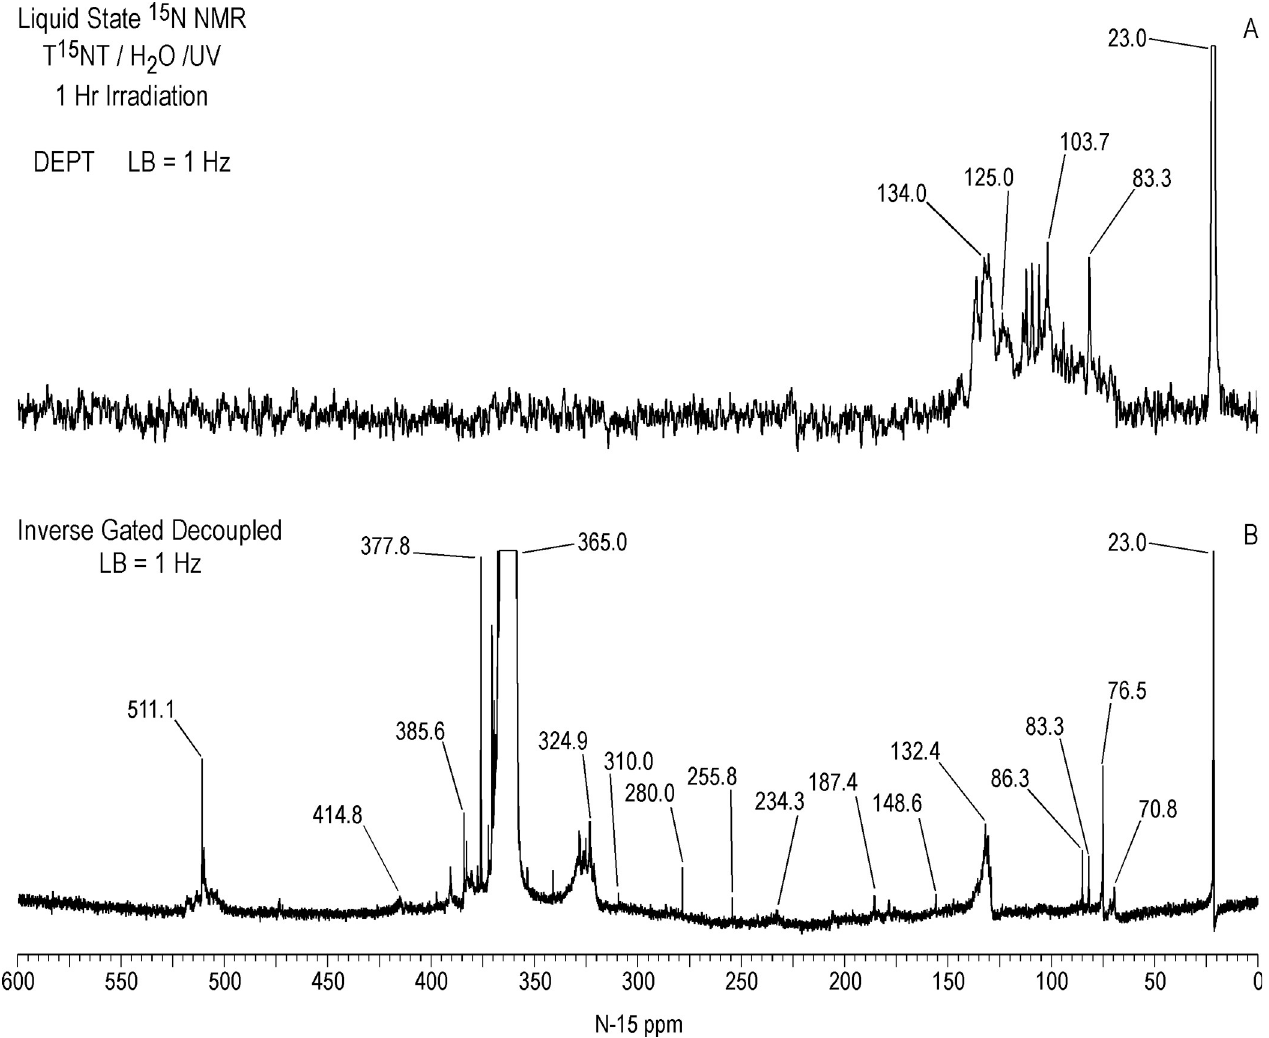
Fig 12. Liquid state N-15 NMR spectra of T 15 NT subjected to lamp irradiation in deionized water. A. DEPT spectrum showing all nitrogens bonded to protons in positive phase. B. IGD spectrum. LB = line broadening.